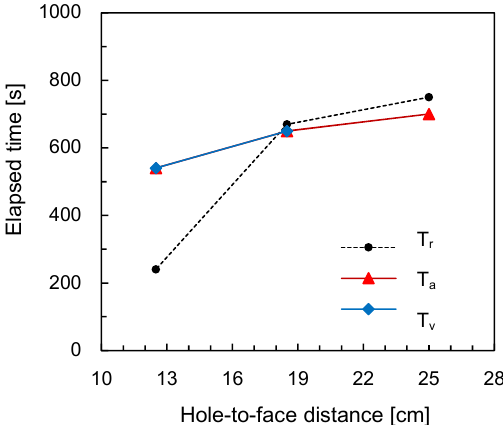
Figure 10. Variation in the elapsed time until crack propagation according to the hole-to-face distance. T r denotes the elapsed time recorded by observation. T v and T a indicate the elapsed times until the decrease in the velocity and amplitude of elastic waves, respectively.